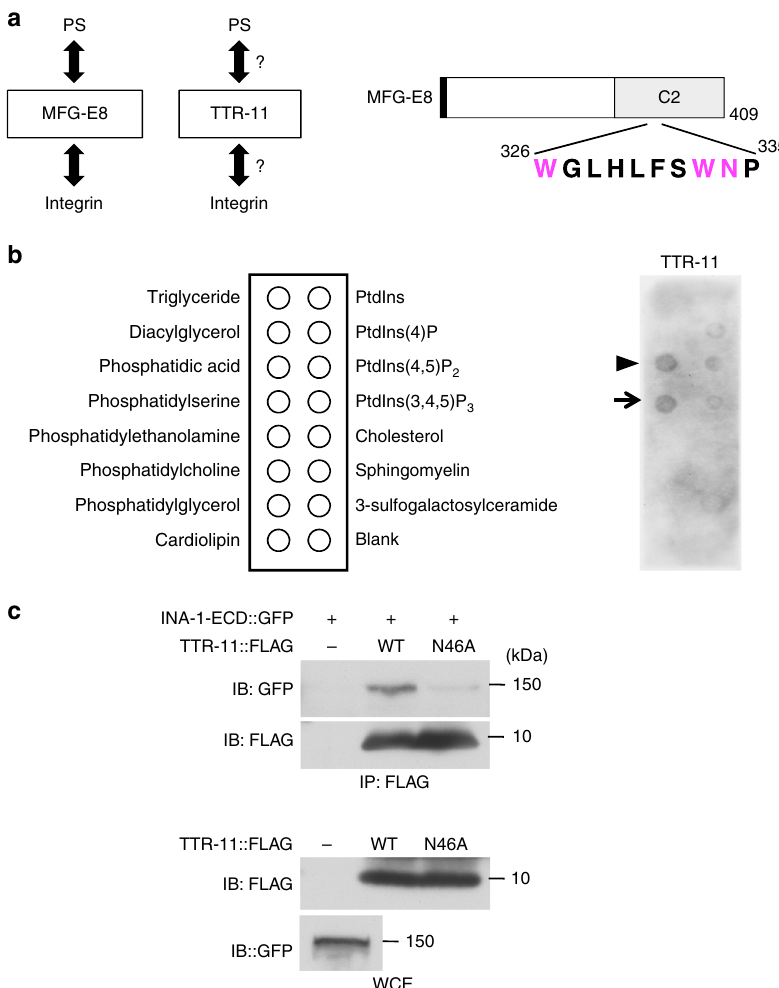
Fig. 2 TTR-11 associates with both phosphatidylserine (PS) and integrin. a Comparison of the functions between MFG-E8 and TTR-11. Schematic diagram of MFG-E8 is shown in the right part. The black box indicates the predicted secretion signal. A C2 domain (C2) is also indicated. Three amino acid residues within the C2 domain (Trp-326, Trp-333, and Asn-334) essential for its PS binding are indicated in magenta. b Binding of TTR-11 with phospholipids. Af fi nity-puri fi ed TTR-11::FLAG bound to phospholipids on a membrane lipid strip. An arrow and an arrowhead indicate phosphatidylserine and phosphatidic acid, respectively. c Interaction of TTR-11 with the INA-1 extracellular domain in vitro. HEK293 cells were transfected with plasmids encoding INA-1-ECD:: GFP and TTR-11::FLAG (wild type and N46A) separately. Cell extracts were prepared from each cell and mixed in vitro. Complex formation was detected by immunoprecipitation (IP) with an anti-FLAG antibody, followed by immunoblotting (IB) with an anti-GFP antibody. Whole-cell extracts (WCEs) were analyzed by